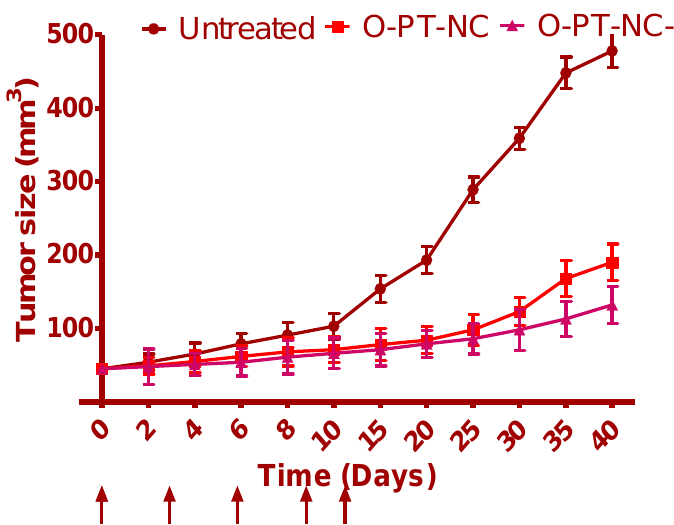
Figure 9. Tumor growth inhibition effect of O-PT-NC and O-PT-NC-Folate in the NCI/ADR-RES xenograft model. (Solid arrows indicate the days of intravenous administration.)